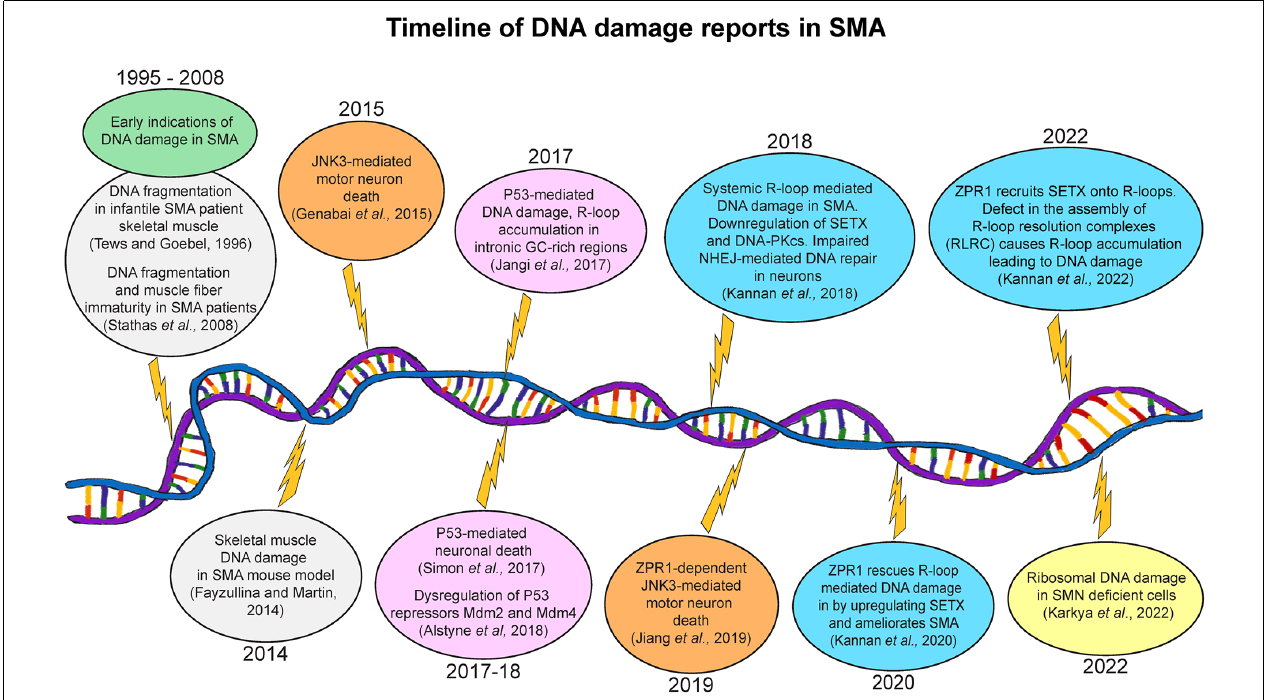
FIGURE 2 | Graphical representation of timeline of DNA damage reports in SMA. Early reports indicating the possibility of DNA damage in SMA muscle tissue (1996–2008) followed by substantial reports with studies uncovering the molecular basis of R-loop-dependent DNA damage in the pathogenesis and the rescue of SMA disease